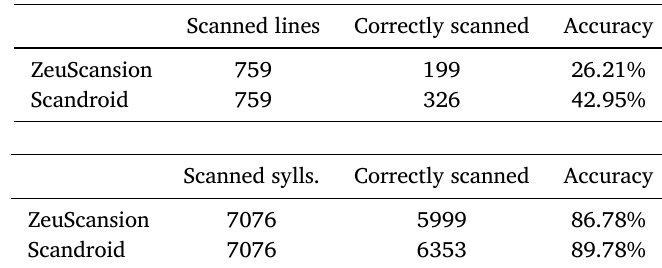
Scanned lines Correctly